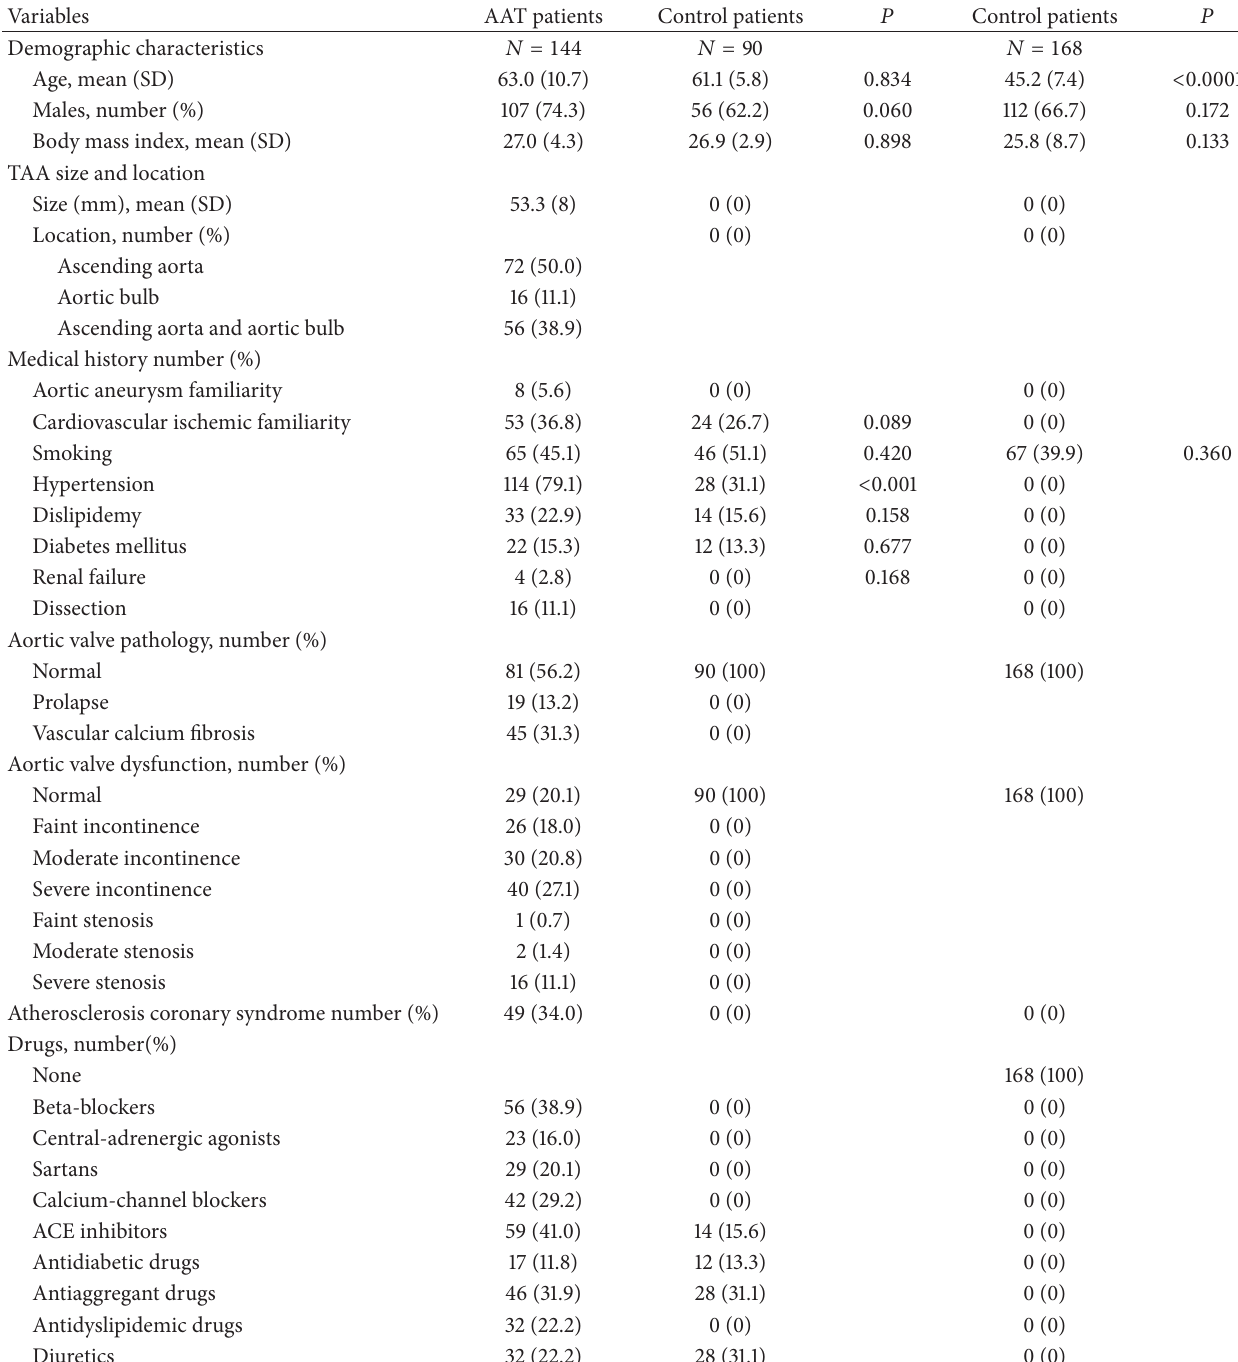
Table 1: Demographic and clinical characteristics of TAA patients and control